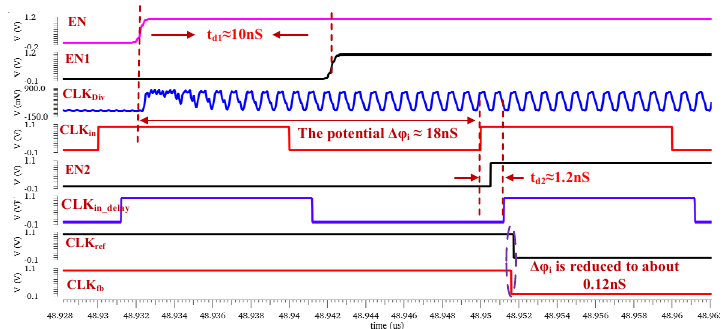
Figure 18. The simulation results of the proposed phase error reduction under clock synchronization and delay compensation.